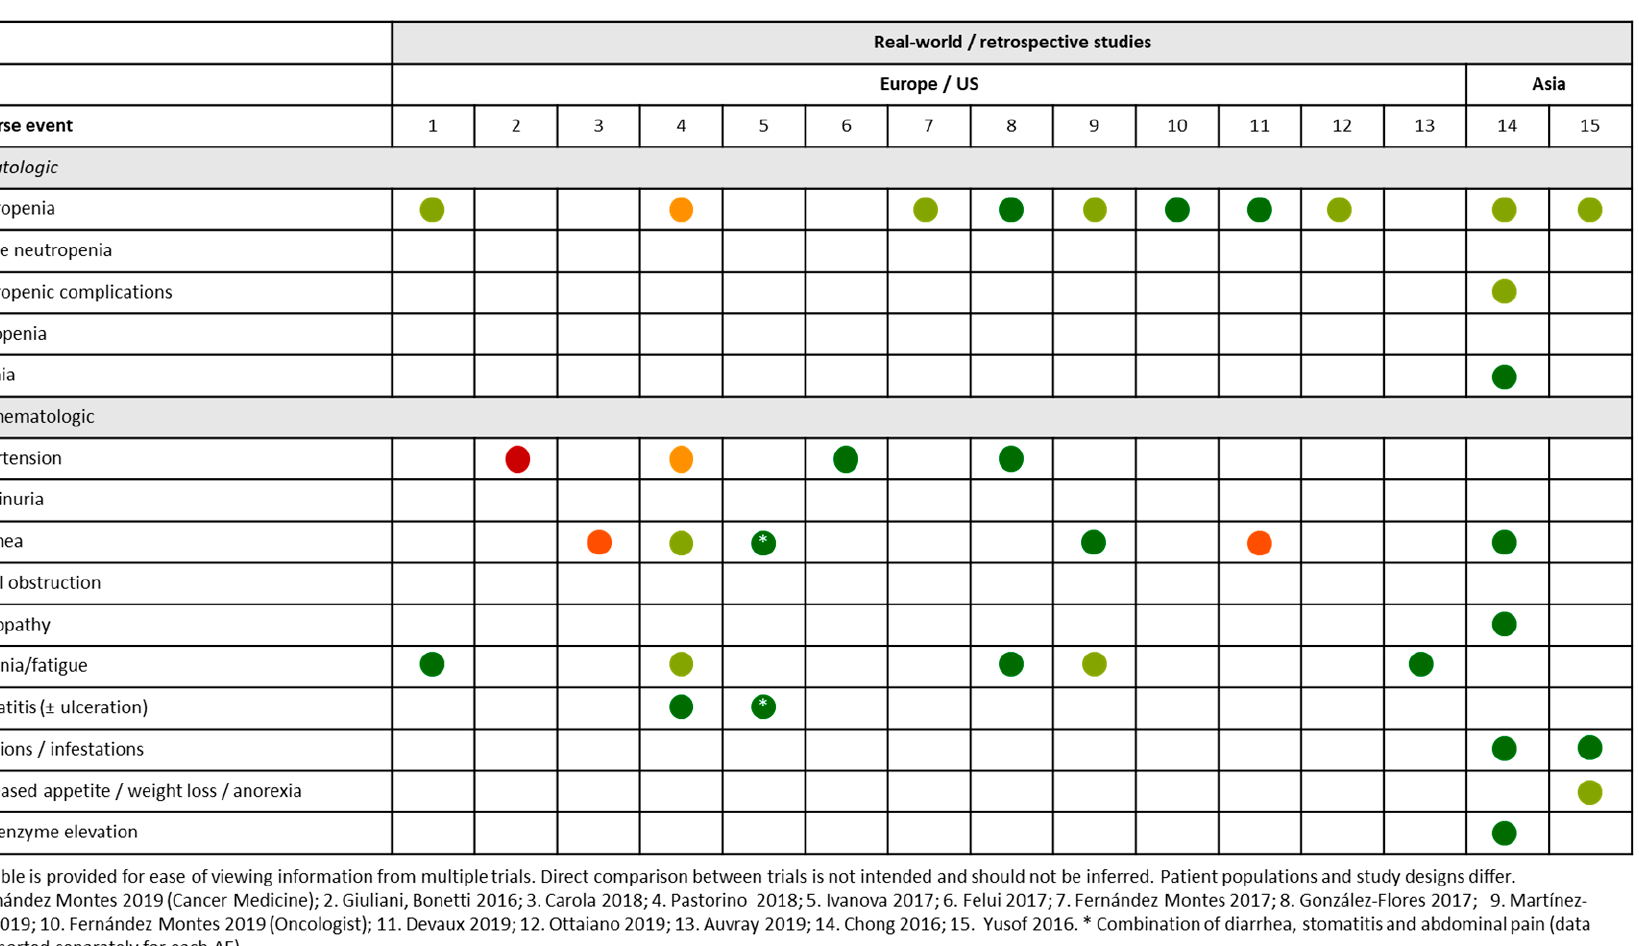
Figure 4. Summary of Grade ≥ 3 adverse events occurring in ≥ 10% of patients across real-world or retrospective studies of aflibercept in patients with mCRC